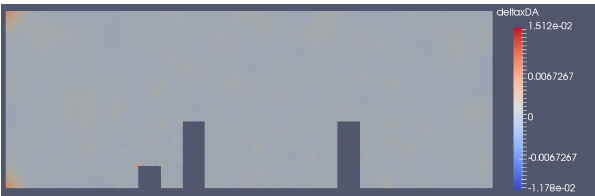
Fig. 7 Results of the VarDA algorithm with (cid:28)(cid:28)(cid:28) =5 EOFs for Velocity field.